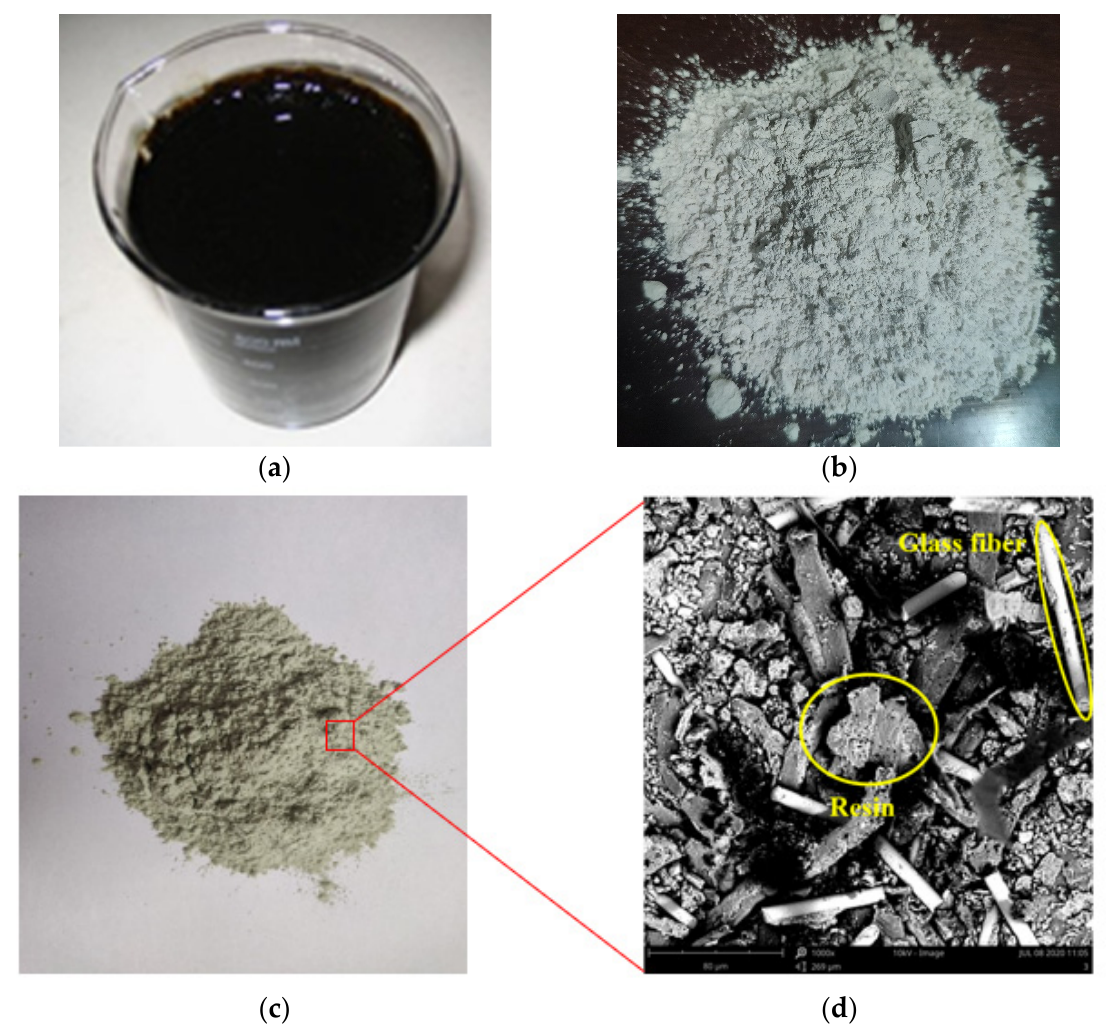
Figure 1. Raw materials: ( a ) 70# ( b ) SBR ( c ) printed circuit boards (PCBs) powder ( d ) SEM picture of PCBs powder The aggregate used was diabase produced and processed in Nanning, Guangxi, China.